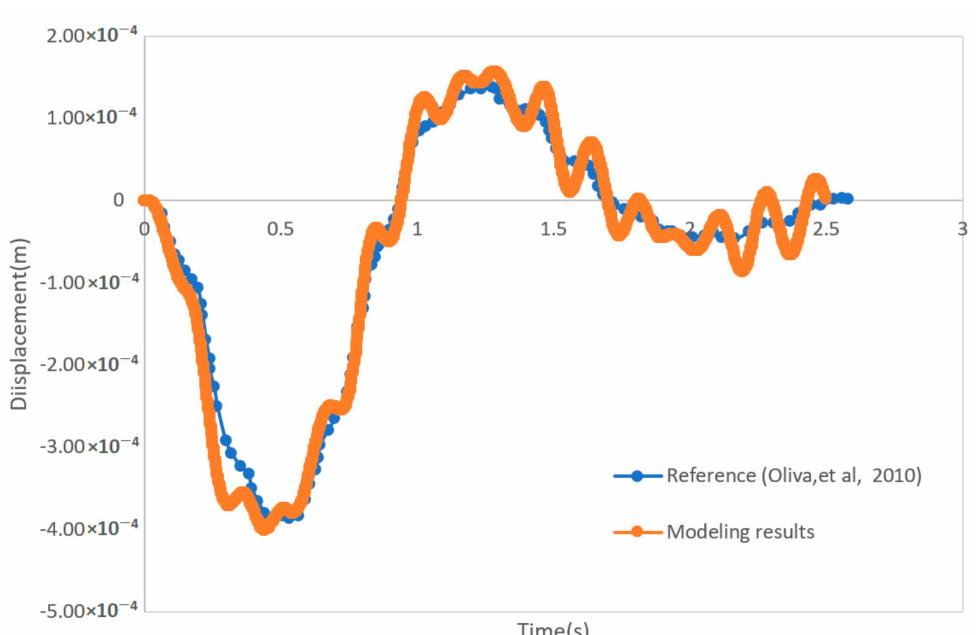
Figure 14. The mid-span displacement time history of the first span when the truck passes at 32.5 m/s.